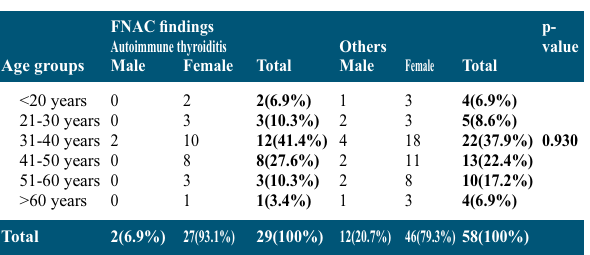
Table 2: Comparison of age groups of patients with FNAC ndings of thyroid lesions